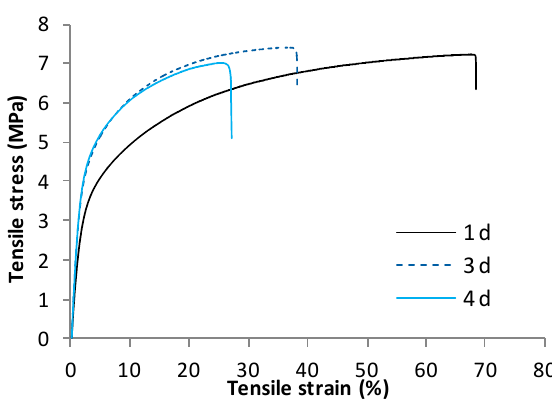
Figure 2. Mechanical properties for thermocompressed TPS/S:G 1:2 films with different storage time (at ambient temperature) before melt processing.